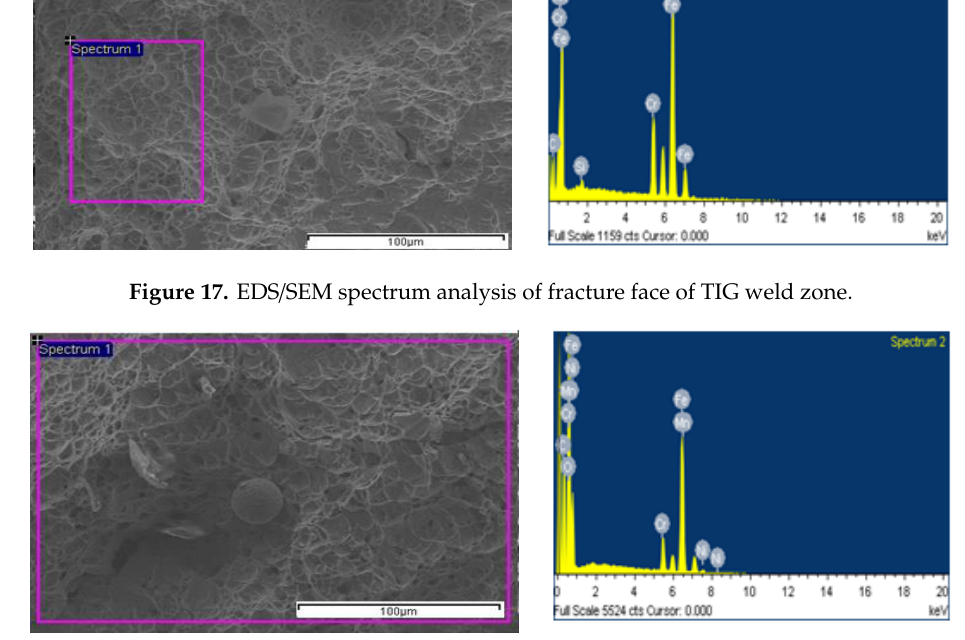
Figure 18. EDS / SEM spectrum analysis of fracture face of ATIG weld zone. Figure 18 EDS/SEM spectrum analysis of fracture face of ATIG weld zone. Table 12. Elements present in fracture face of ATIG weld zone.